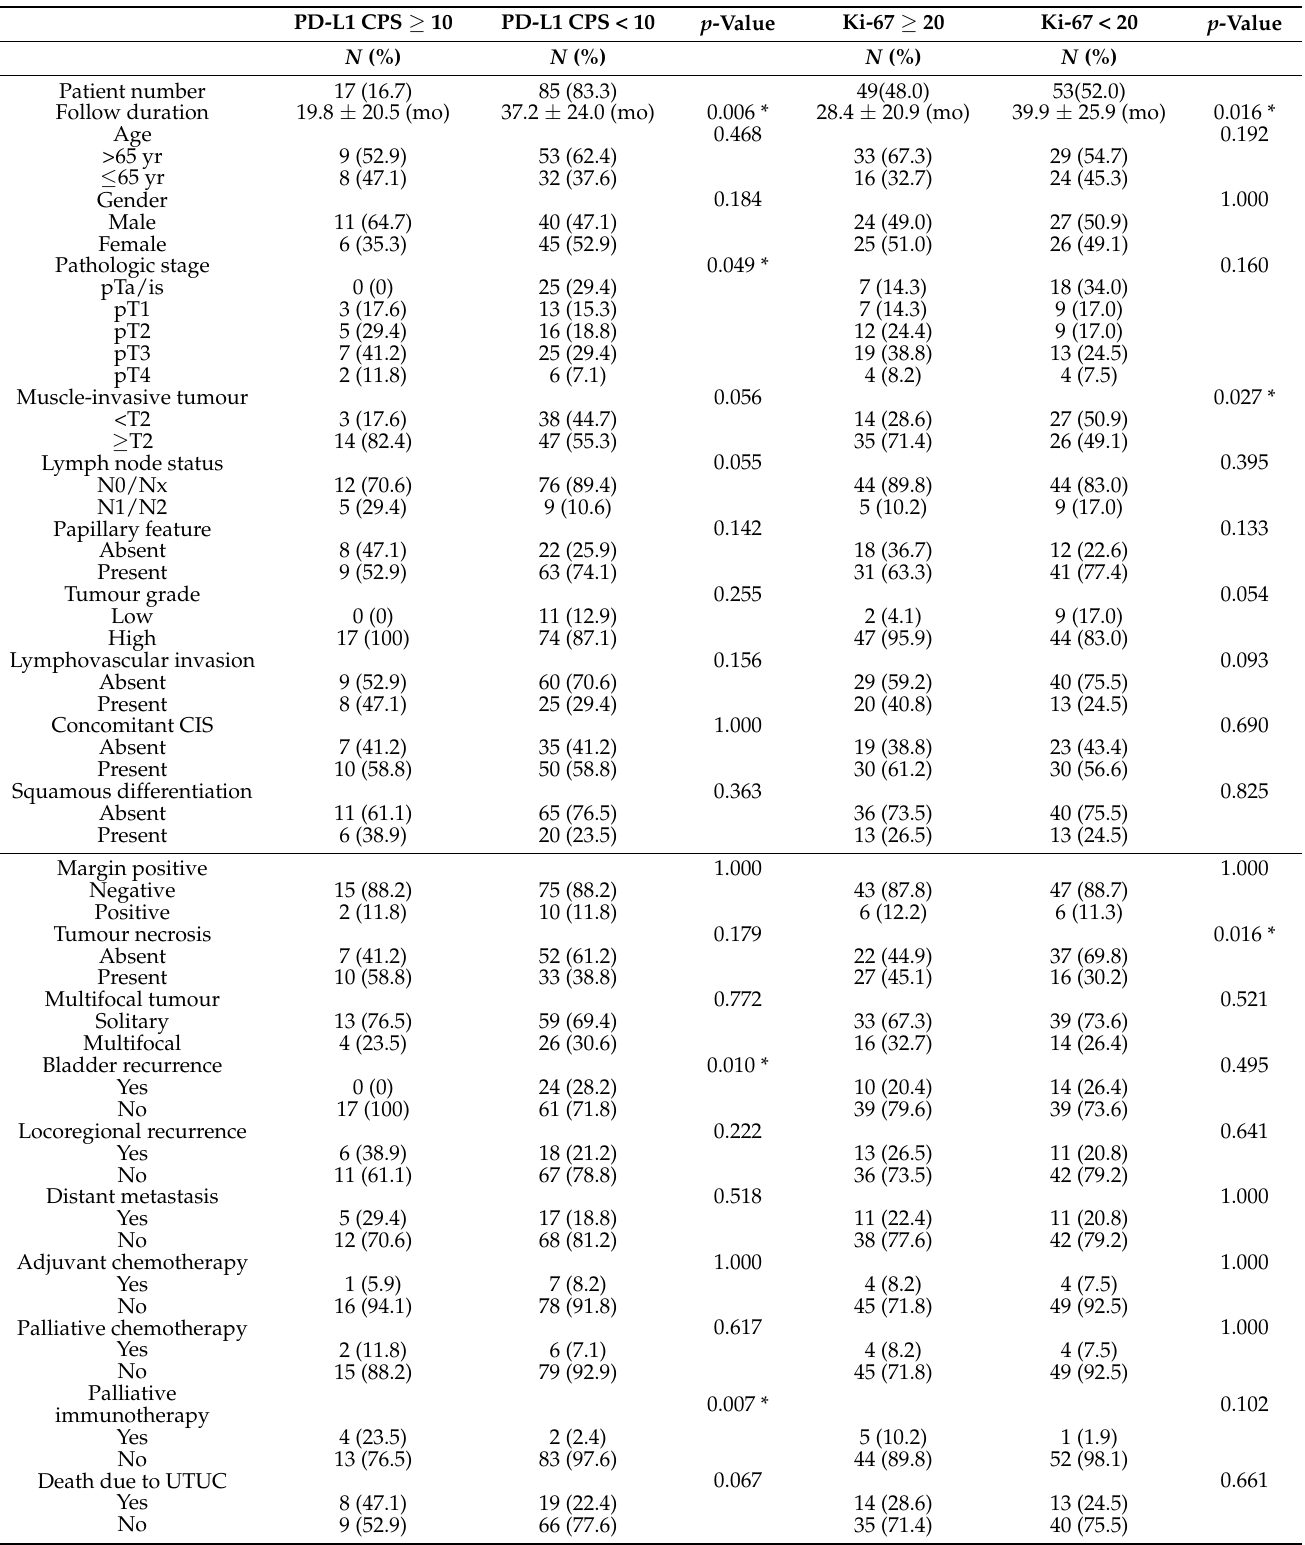
Table 2. The association of PD-L1 expression and Ki-67 expression with the clinicopathological characteristics in patients with